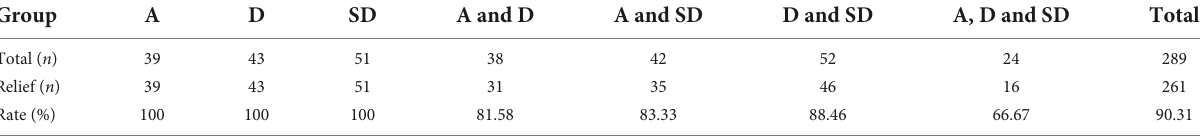
TABLE 3 Symptom relief of subjects with different clinical manifestations. Group